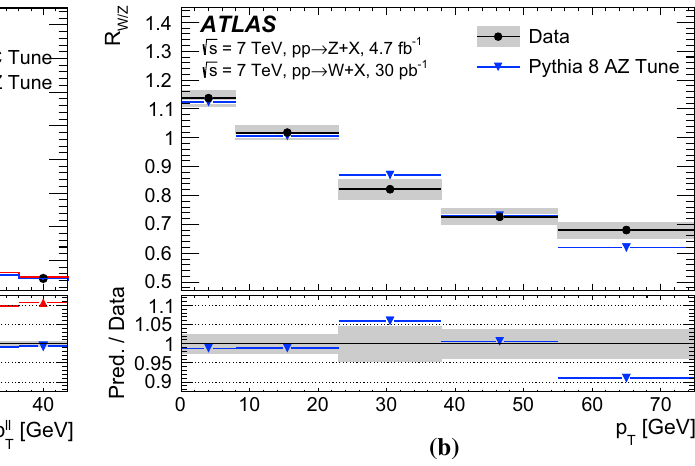
in compared to the predictions of the Pythia 8 AZ tune and, in a , of T the Pythia 8 4C tune. The shaded bands show the total experimental uncertainties